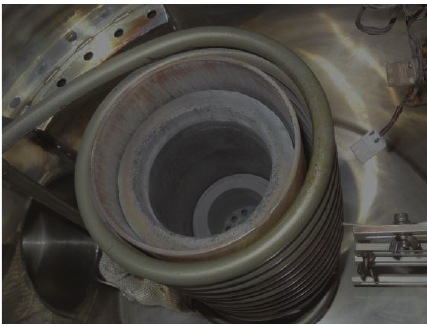
Figure 1: Induction copper coil used for heating the raw